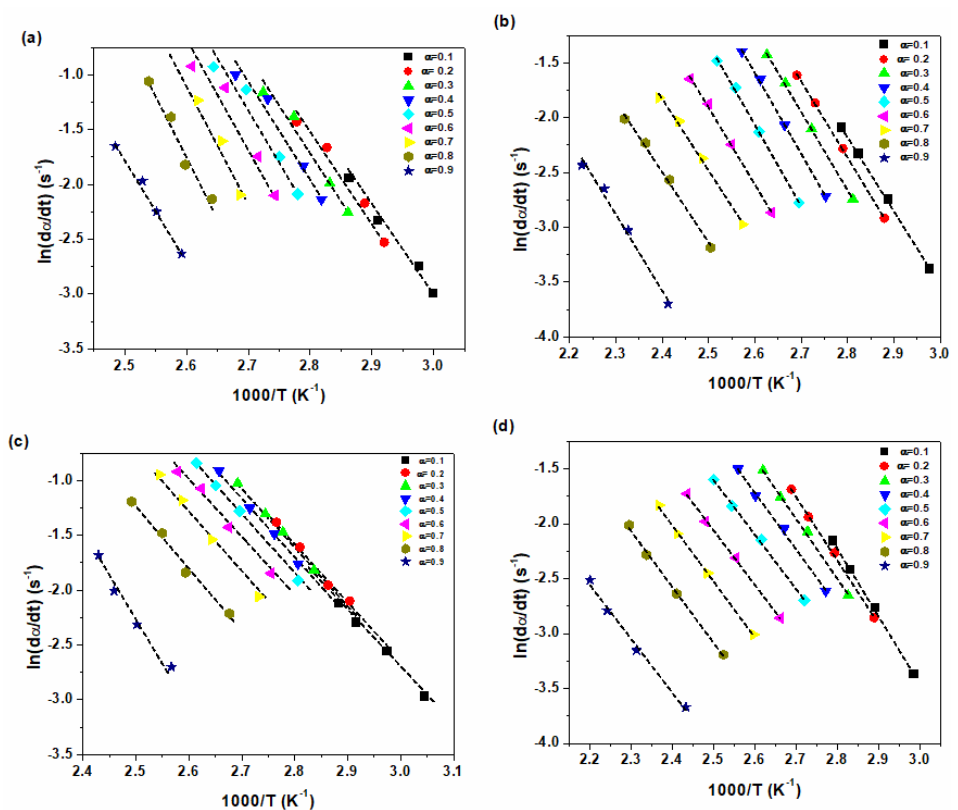
Figure 3. Plots of ln(d α / dt) vs. 1 / T for ( a ) epoxy resin, ( b ) epoxy / P-HNT and ( c ) epoxy / A-HNT and ( d ) epoxy / F-HNT nanocomposites based on Friedman model.